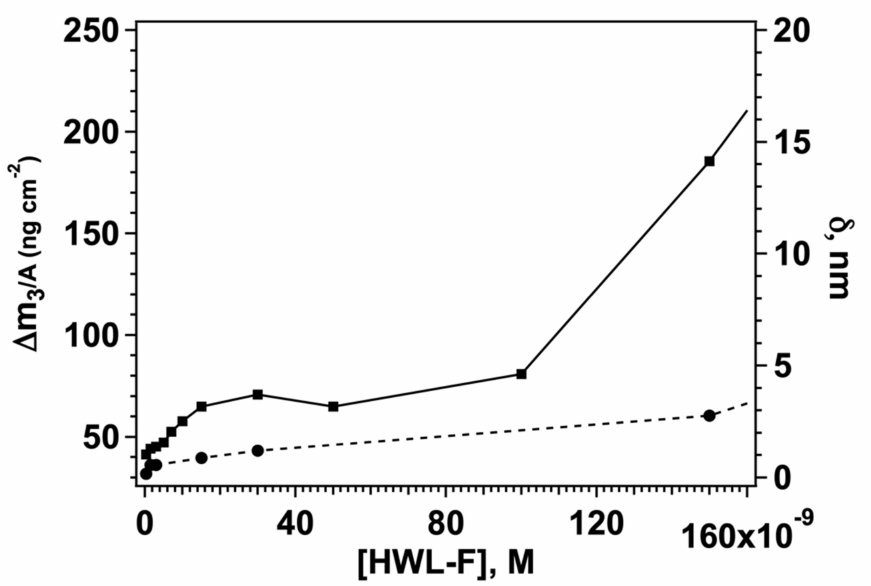
Figure 5. Adsorbed mass (solid line, left y -axis) and adsorbed layer thickness (dashed line, right y -axis) for HWL-F adsorbed on the GO-AgNC/NS